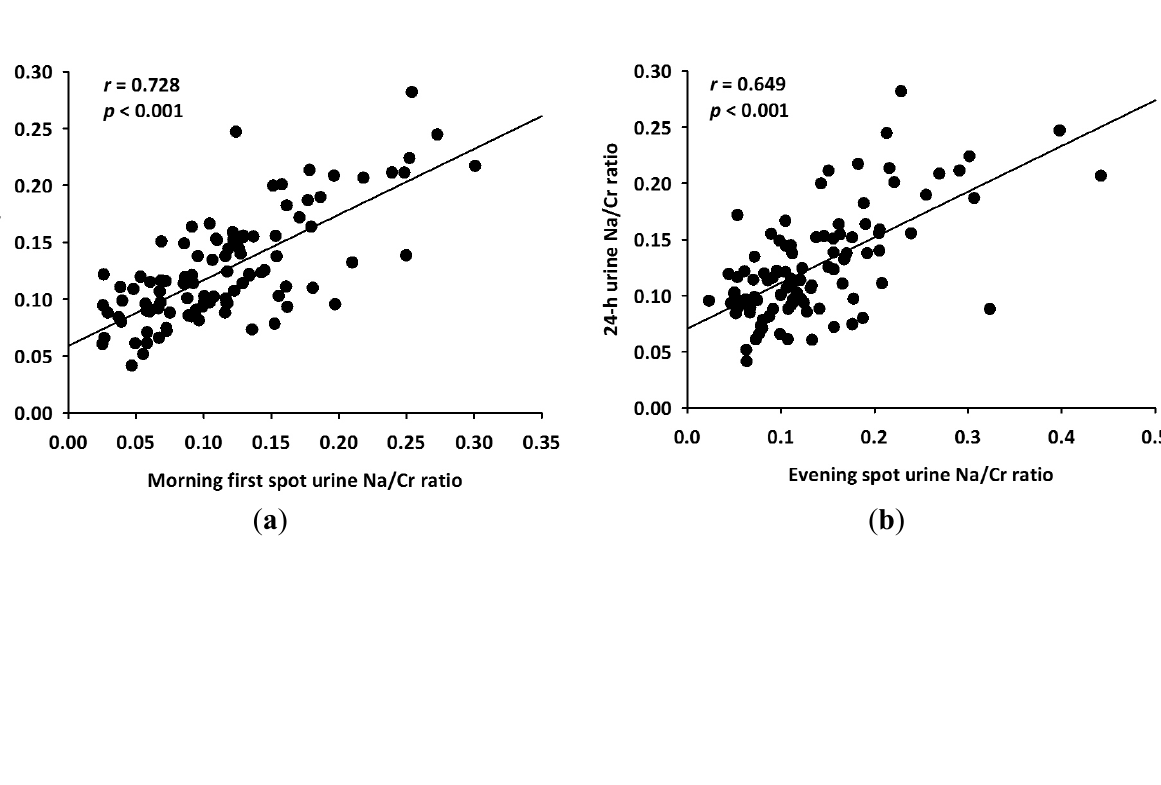
Figure 1. Relationship between ( a ) 24-hour urine sodium/creatinine (Na/Cr) ratio vs . first-morning spot urine Na/Cr ratio; ( b ) 24-hour urine Na/Cr ration vs . evening spot urine Na/Cr ratio; and ( c ) 24-hour urine Na/Cr ration vs . random morning spot urine Na/Cr